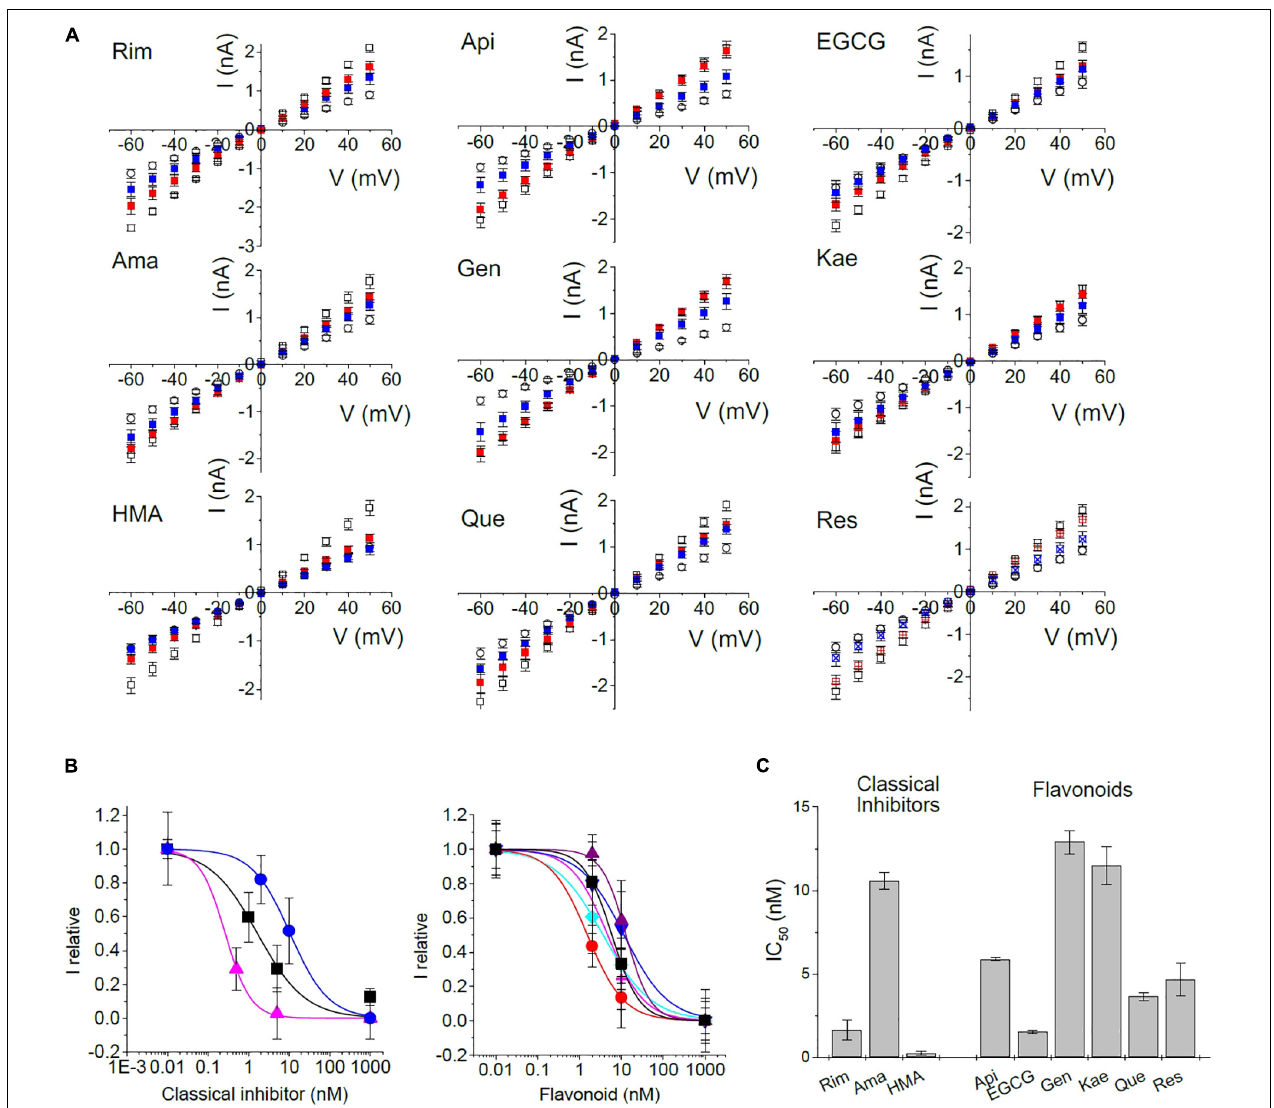
FIGURE 6 | Concentration dependence of inhibition. To gain information about half-maximum inhibiting concentrations (IC 50 ), IV-ramps were recorded at several concentrations of inhibitor. (A) Open circle: control currents (pRK5); open square: currents induced by E protein expression in the absence of inhibitor; red: currents at 2 nM of inhibitor, except Rim (1 nM) and HMA (0.5 nM); blue: currents at 10 nM of inhibitor except Rim and HMA (5 nM). (B) Concentration-response curves constructed from a non-linear fit of data shown in panel (A) . Left panel: black squares – Rim; blue circles – Ama; pink triangles – HMA; right panel: black square – Api; red circle – EGCG; purple up triangle – Gen; blue down triangle – Kae; turquoise diamond – Que; pink plus – Res. (C) Summary of IC 50